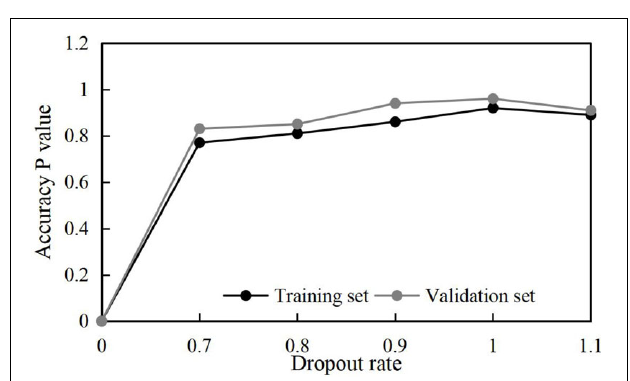
FIGURE 4 | Training accuracy at different batch sizes.